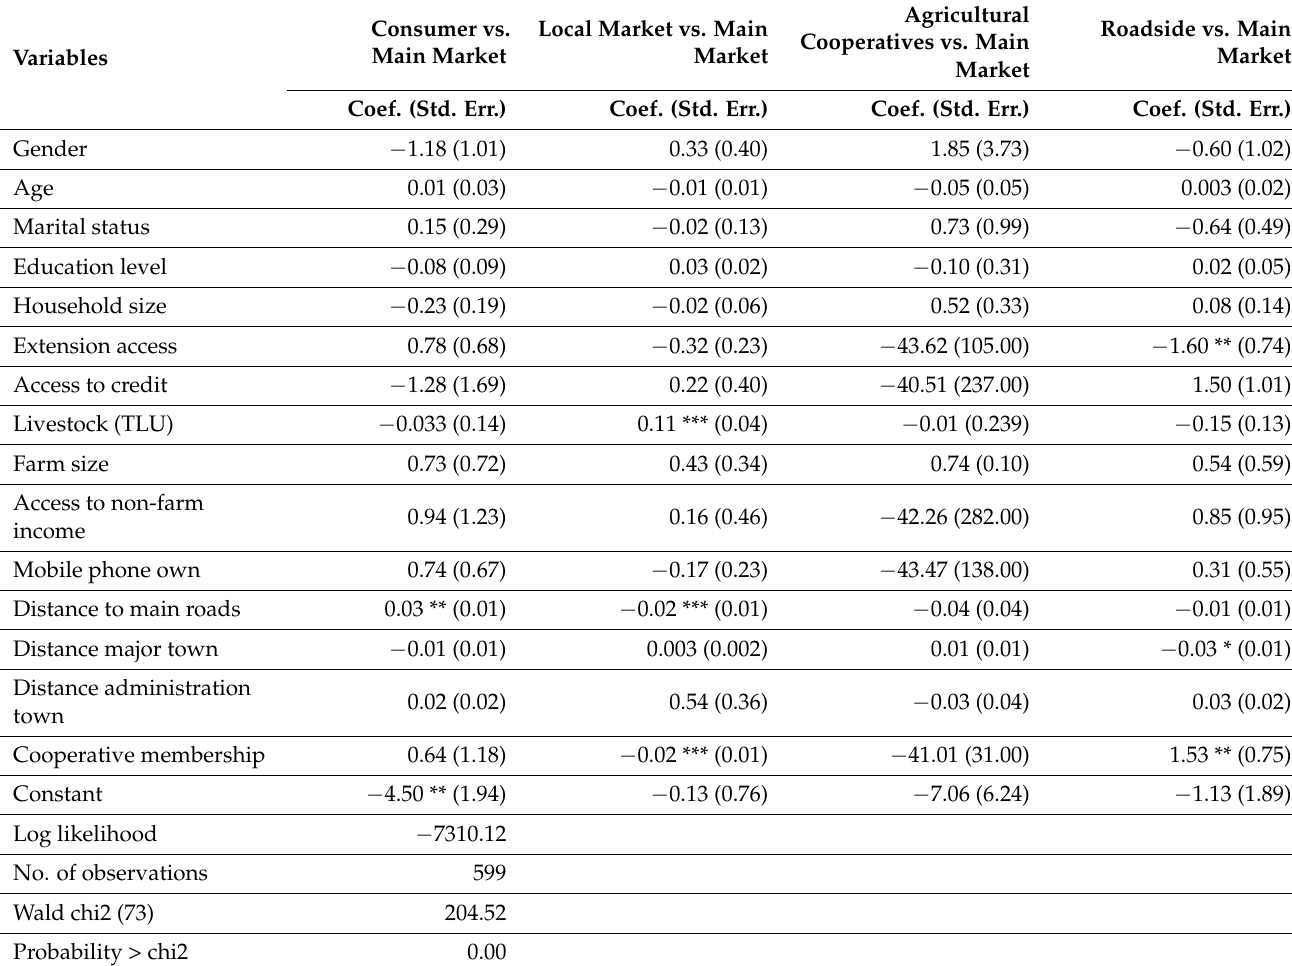
Table 3. Determinants of market outlet choice: mixed multinomial logit